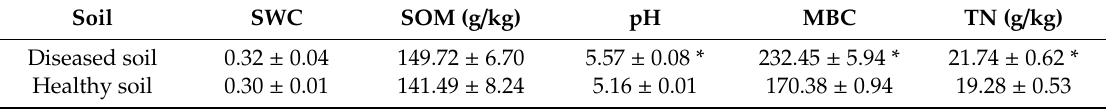
Table 1. The physical and chemical properties in healthy and diseased